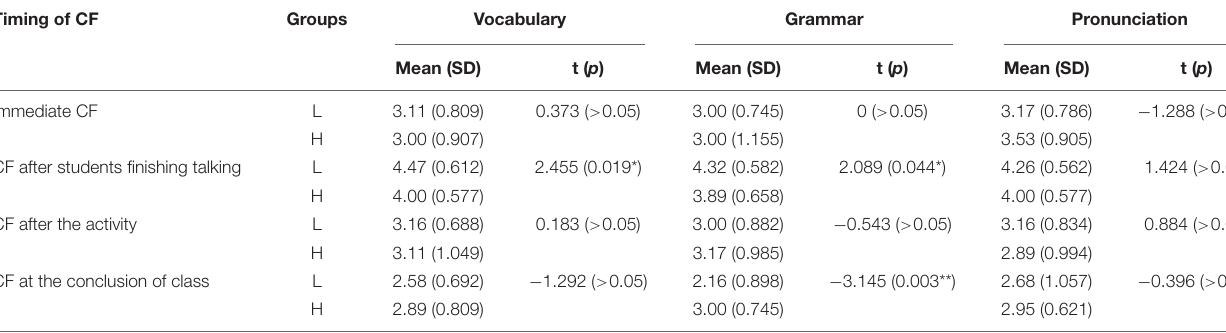
TABLE 1 | High- (H) and low-accuracy (L) group responses to the timing of corrective feedback (CF). Timing of CF Groups Vocabulary